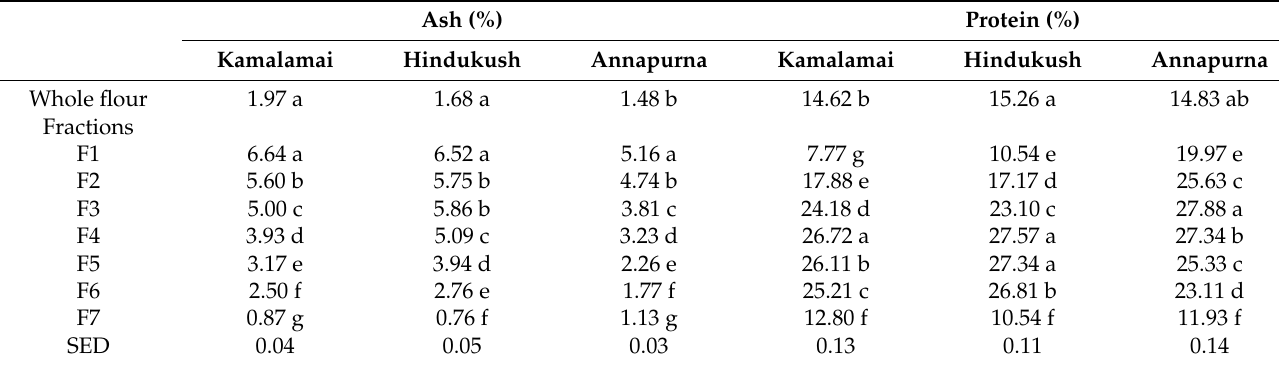
Table 1. Ash and protein contents in whole barley flours and pearling fractions. Ash (%) Protein (%)